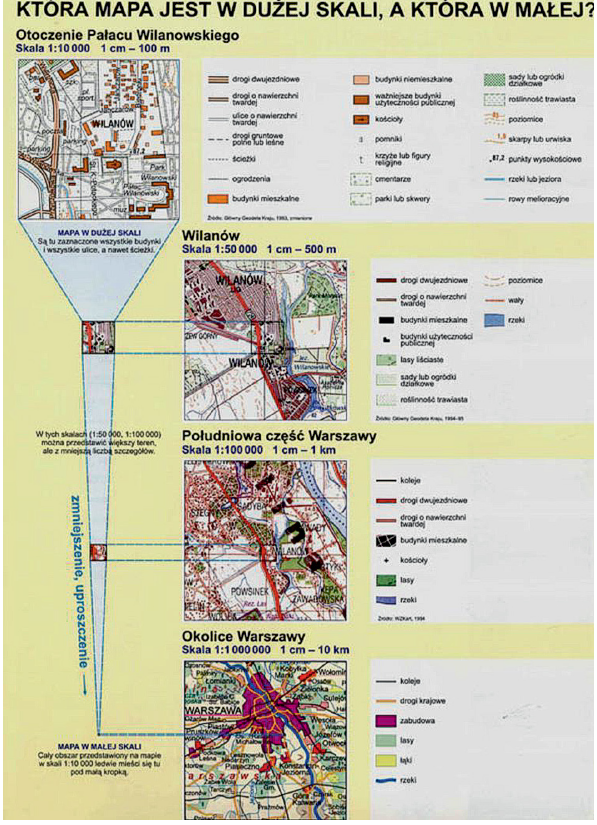
Fig. 2. The comparison of maps at different scales